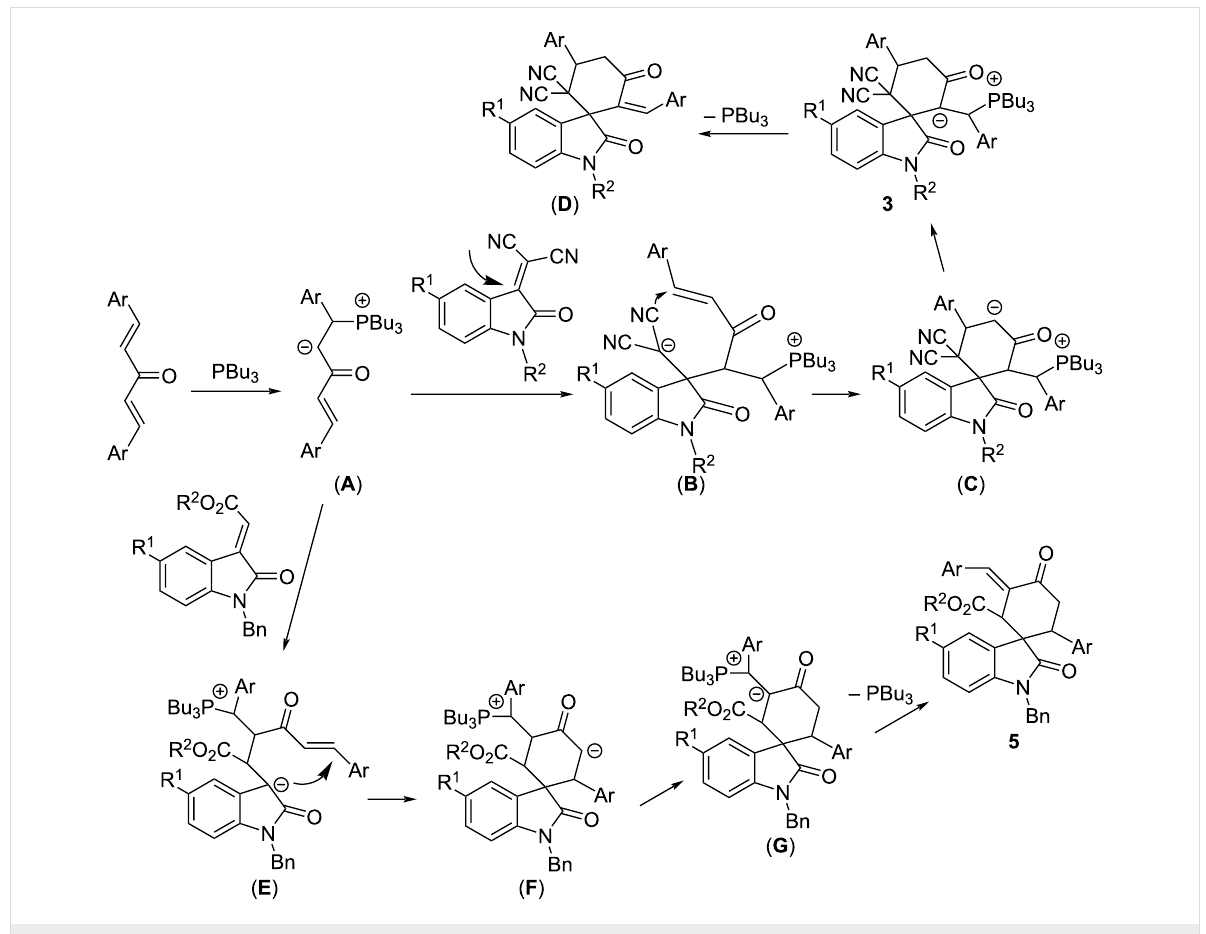
Scheme 1: Proposed reaction mechanism for the compounds 3 and 5 .